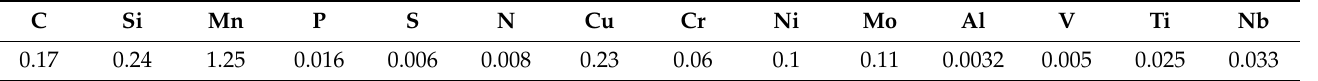
Figure 5. S355J2+N steel, mechanical properties [32]. Table 2. Chemical composition of S355J2+N steel (mass%), [23].